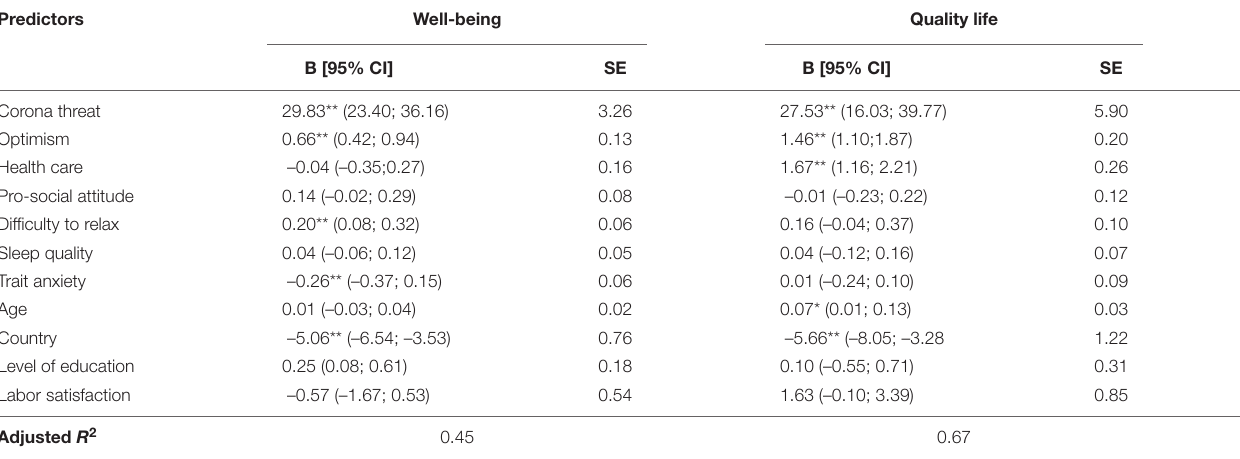
TABLE 5 | Summary of results of multiple regression